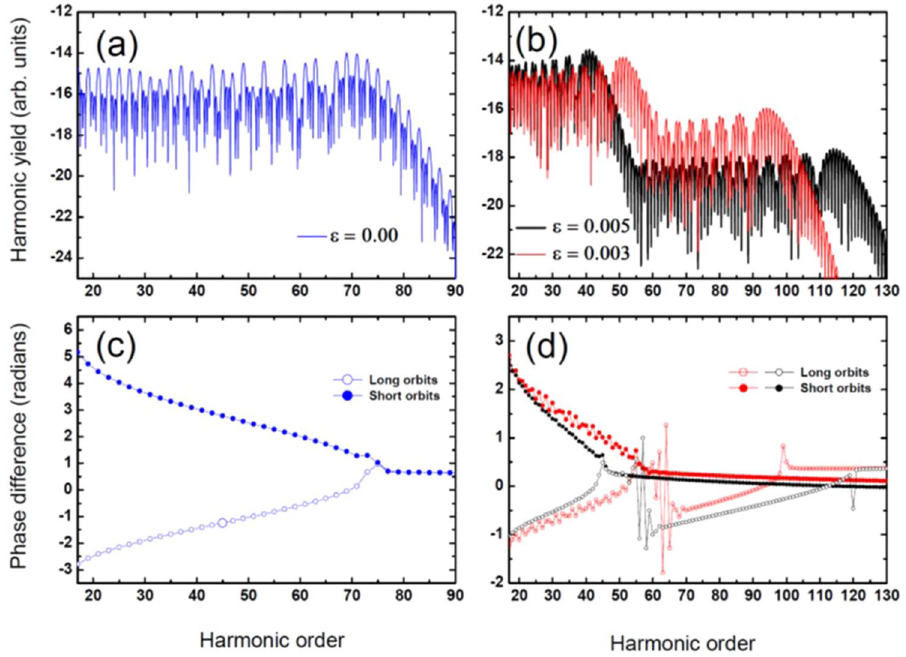
Figure 2. High-order harmonic spectra for a neon atom ( I p = 0.793 a.u.) interacting with a monochromatic field of frequency ω = 0.055 a.u. (wavelength of 825 nm) and intensity I = 4 10 14 W/cm² . In panel (a) the blue curve depicts the case with ε = 0, whereas panel (b) the red and black curves show the cases with ε = 0.003 and ε = 0.005 inhomogeneity factors respectively. The yields are represented in logarithmic scale. Panels (c) and (d) present the calculated phase difference for the homogeneous case (blue curve) and for the inhomogeneous cases for ε = 0.003 (red) and ε = 0.005 (black) inhomogeneity